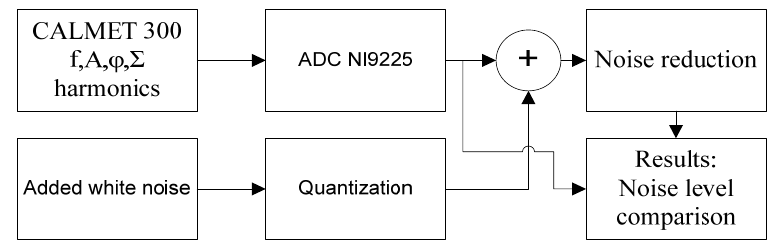
Figure 12. Block diagram of measurement system.